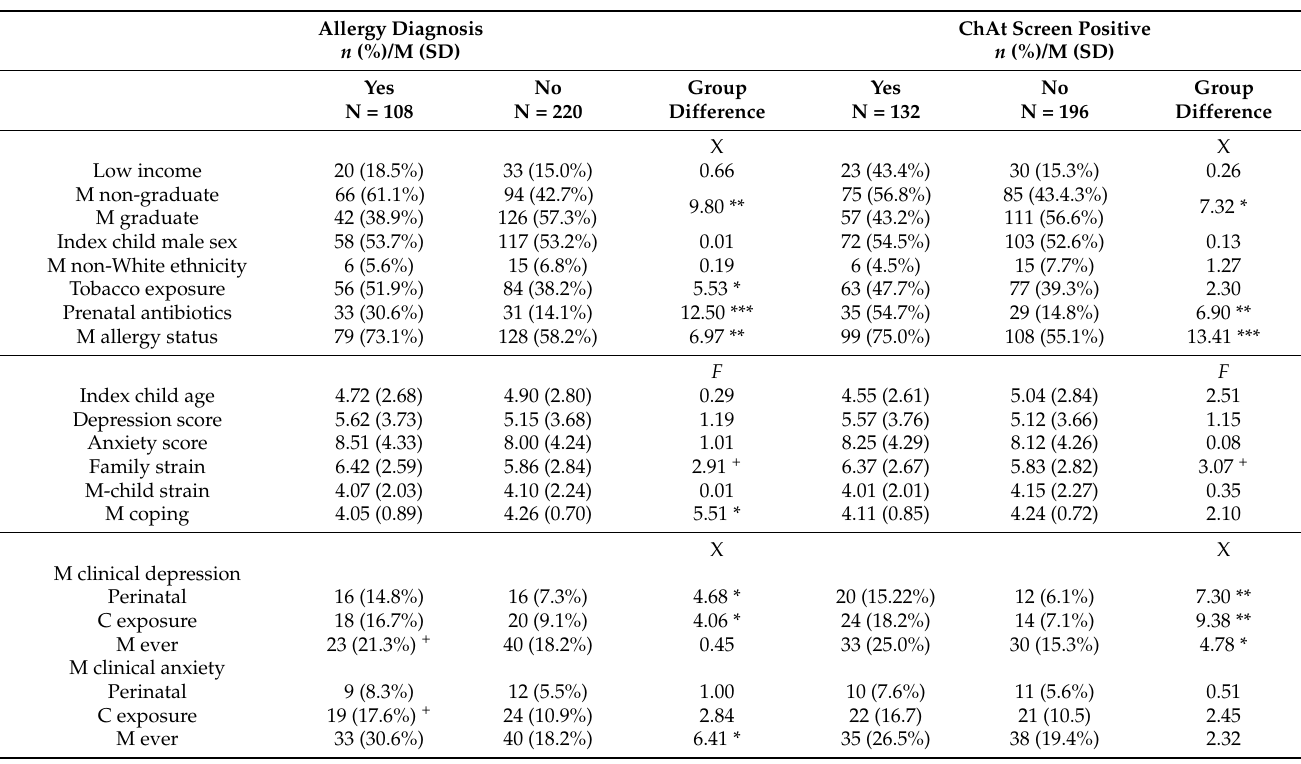
Table 1. Child allergy group differences by allergy-related, family/clinical, and sociodemographic variables: descriptive statistics, chi square tests, and analyses of variance (N =